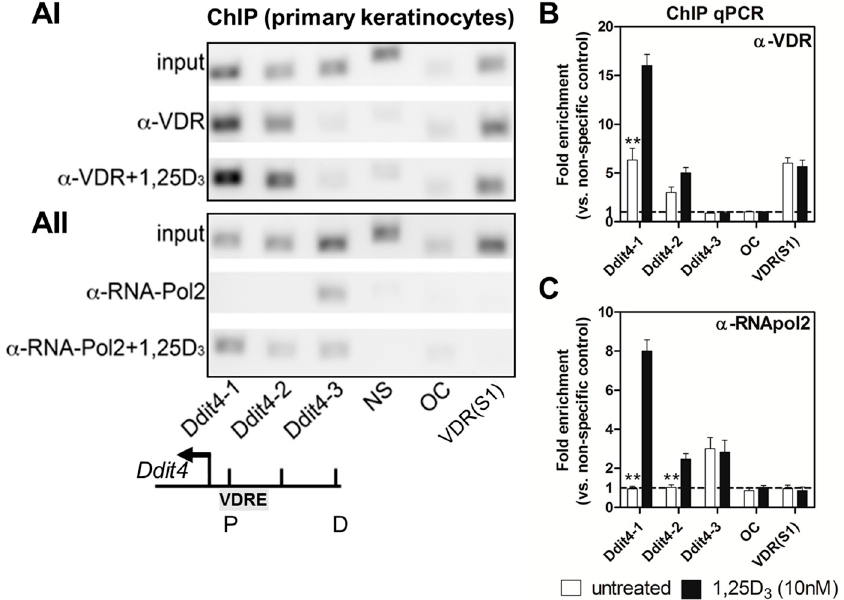
Figure 3. Ddit4 transcriptional activity is directly regulated by the VDR within primary epidermal keratinocytes (1.5 column). ( A ) Representative chromatin immunoprecipitation (ChIP) gel images of VDR and RNA polymerase 2 (RNApol2) interactions at the Ddit4 promoter region within WT primary keratinocytes. Figure 3(AI) shows VDR immunoprecipitation, while Figure 3(AII) shows RNApol2 immunoprecipitation results. Cells were treated with 1,25D 3 (10 nM) for 15 min, fixed and then the chromatin was purified. NS (non-specific), OC (osteocalcin), and VDR-S1 (VDR intron 3 and 4) genomic sites were used for control purposes. P (proximal), D (distal), VDRE (putative vitamin D response element); ( B ) ChIP-Quantitative PCR (qPCR) analysis of VDR immunoprecipitation; ( C ) ChiP-qPCR analysis of RNApol2 immunoprecipitation. One-way ANOVA at an α = 0.05 (95% confidence